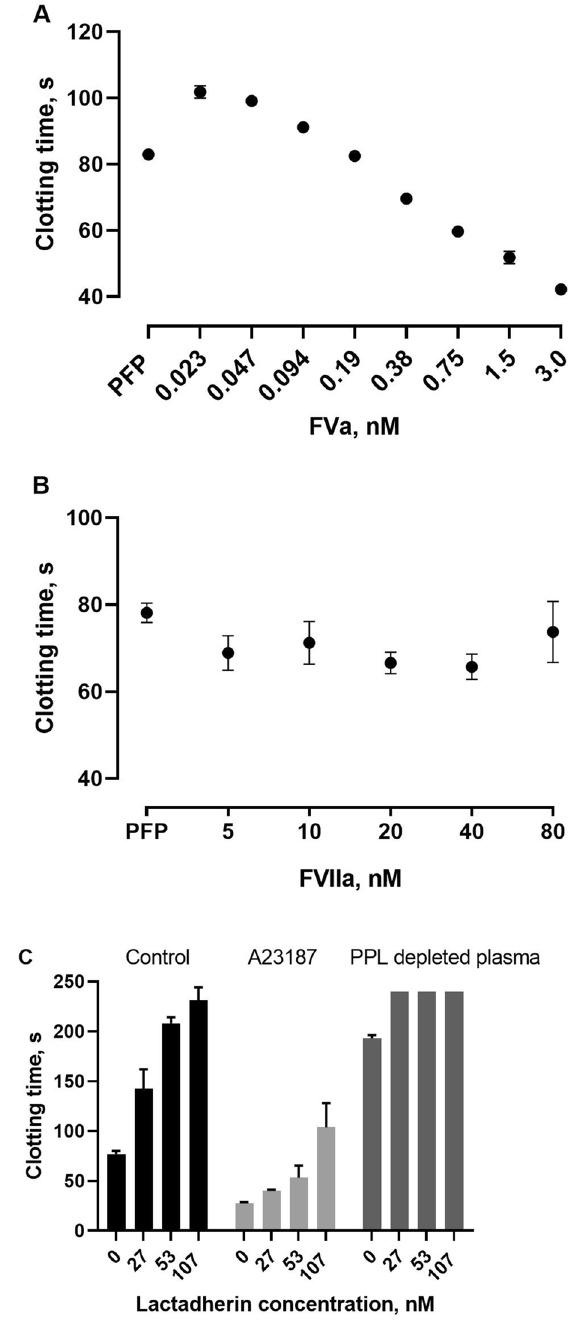
Figure 6. The effect of coagulation factors on the performance of the modified PPL assay. Exogenous coagulation factors were added to the reaction buffer in concentrations from 0.02 to 3.0 nM for FVa (panel A ) and from 5 to 80 nM for FVIIa (panel B ). Panel ( C ) shows the effect of lactadherin pretreatment on the PPL activity of PRP-derived EVs generated by stimulation of PRP by calcium ionophore A23187 for 15 min. Values are means ± 1 SD (n =